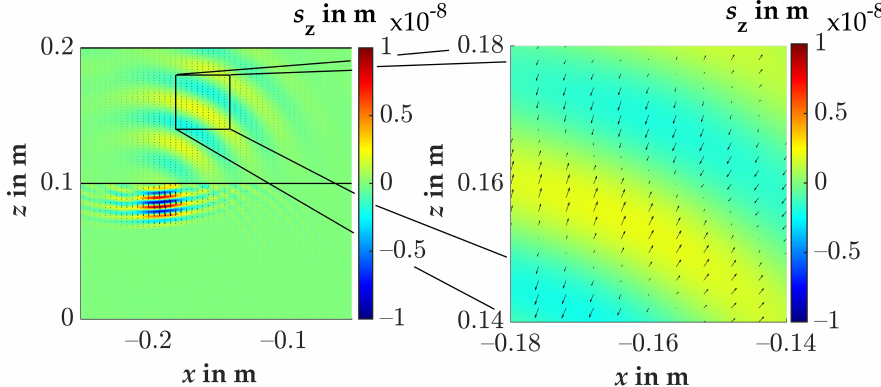
Figure 8. Particle deflection in a cross-section of the calculated volume of Figure 7 at time 0.4 ms with an enlarged section to show with vectors that here, there are longitudinal waves